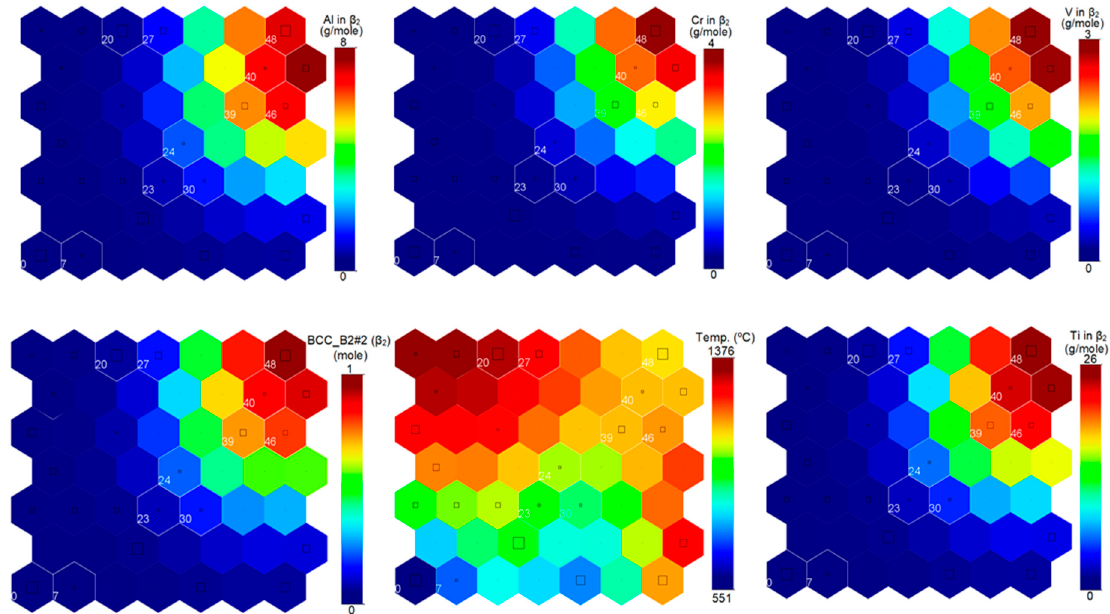
Figure 7. Distribution of alloying elements in the BCC_B2#2 phase.